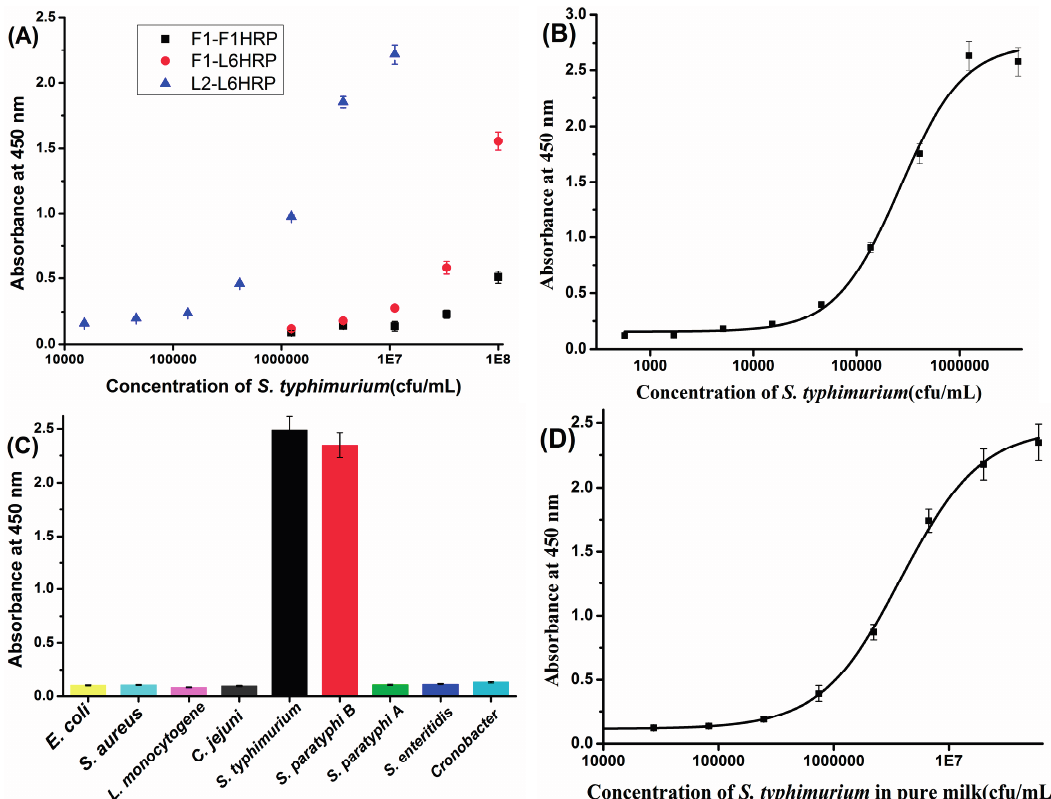
Figure 2. ( A ) Sensitivity of the three types of pair in sandwich ELISA for S. typhimurium. ( B ) Standard curve of L2-L6 HRP in PBST; ( C ) Specificity of the LPS mAb based sandwich ELISA for S. typhimurium ; ( D ) Calibration curve of the LPS mAb based sandwich ELISA for S. typhimurium in pure